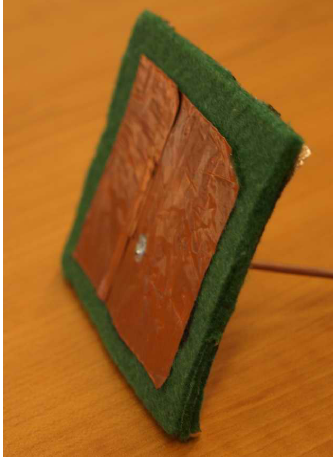
Figure 3. Textile patch antenna (substrate: felt, conducting sections: copper tape) with partially detached copper tape due to environmental